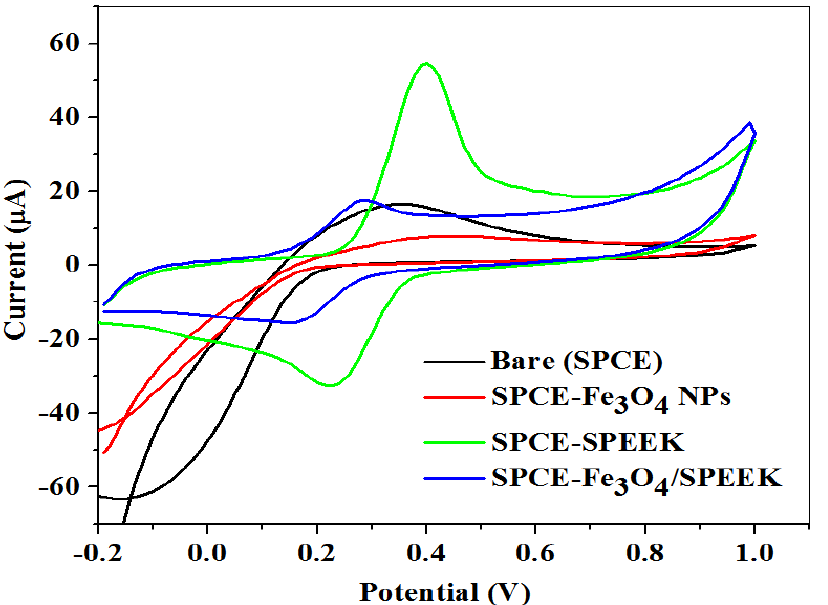
Figure 5. Cyclic voltammogram of the bare and modified electrodes in 5 mM K 3 [Fe(CN) 6 ] prepared in 0.1 M PBS, pH 7.4.